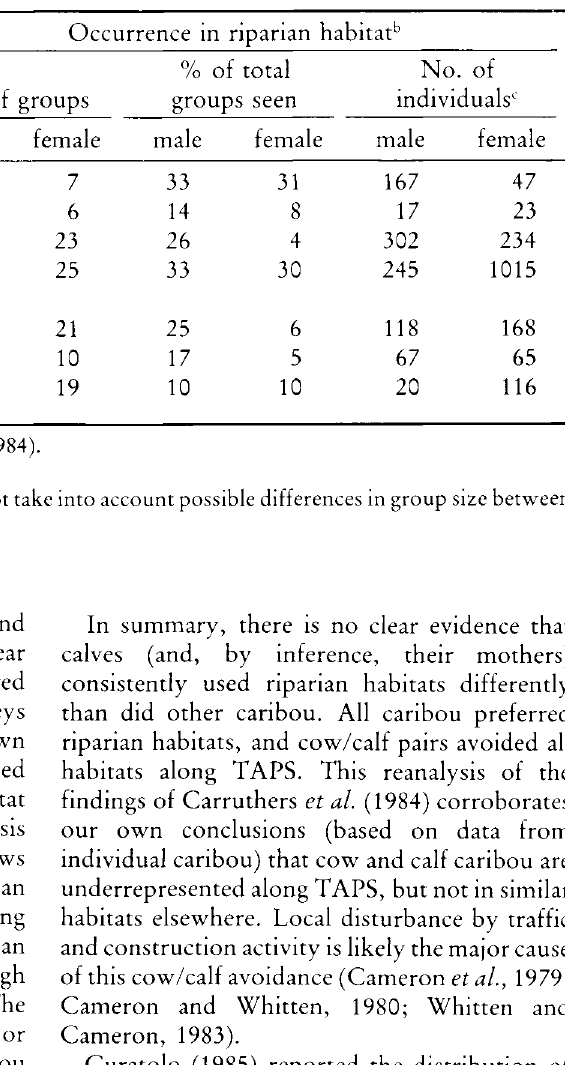
Table 1. Distribution of caribou in male and female groups relative to riparian habitat, Central Arctic Slope, Alaska. 3 Occ urrence in riparian habitat